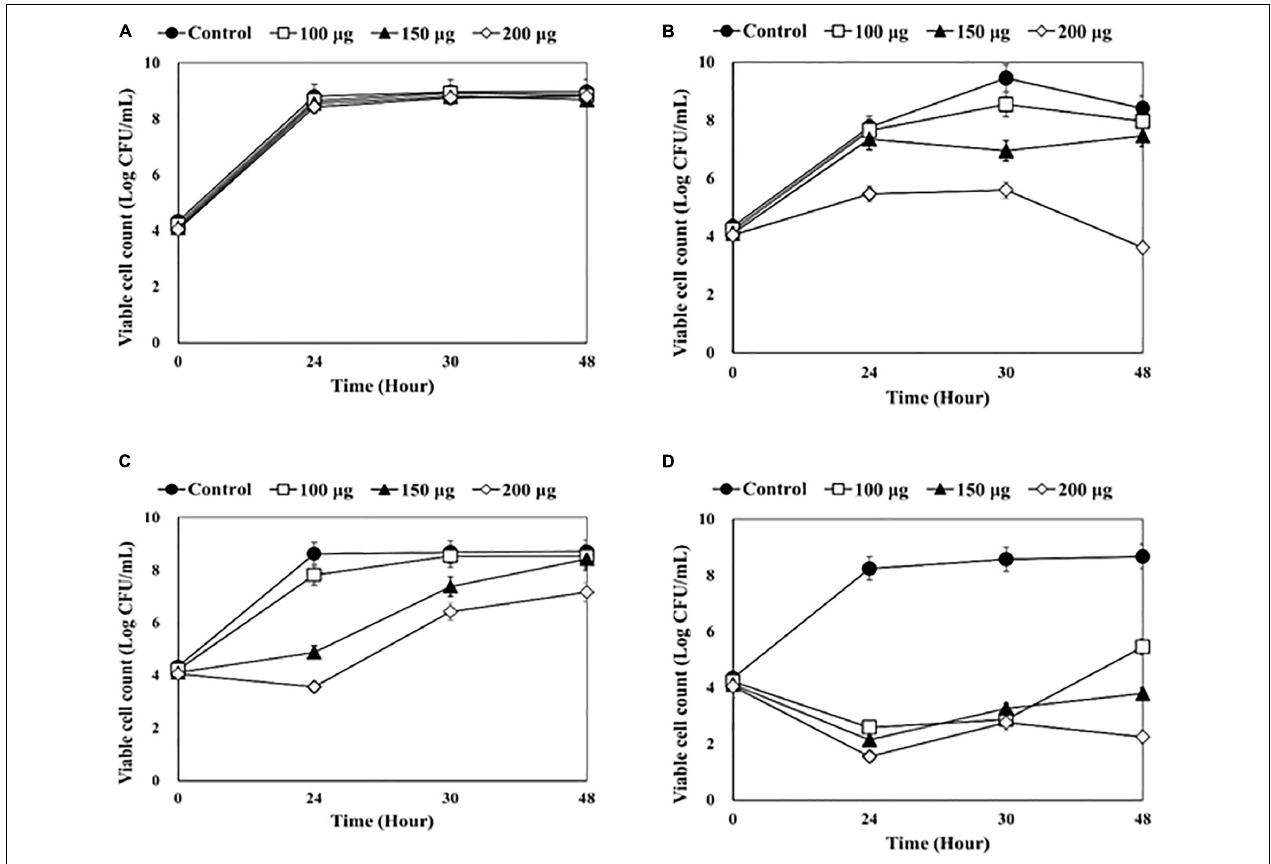
FIGURE 3 | Counting viable bacterial cells after adding endolysin LysSS to the catheter solution. (A) 1-5652, (B) 2-5652, (C) 3-5655, (D) 3-5652-A. These results were statistically evaluated and expressed with standard deviation error bars from three independent